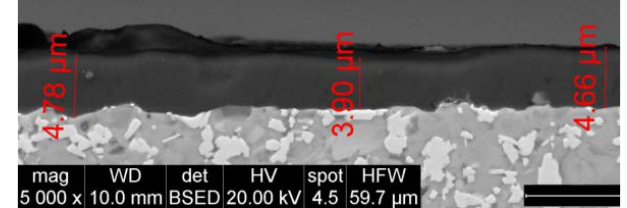
Fig. 1. Structure on cross-section of coating TiAlN, with thickness 4 (±0.8) µm.